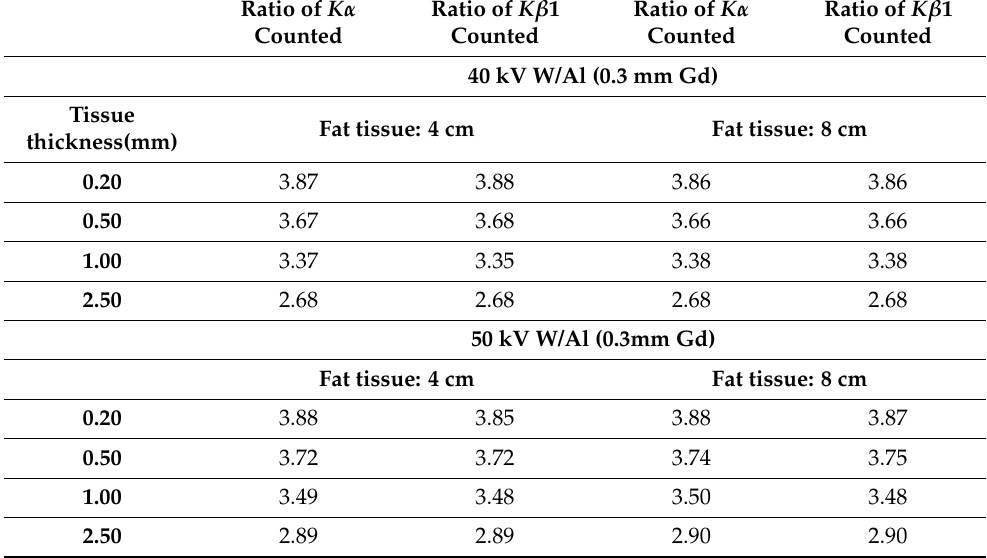
Table 4. Table shows the ratio of K -X-rays counted ( K α and K β 1 ) by the 700 µ m Si converter layer between tumor and fibrous tissue. Results are provided for: (a) two X-ray spectra: 40 kV- W/Al (1.6 mm) and 50 kV- W/Al (1.6 mm) with additional filtration 0.3 mm Gd; (b) two types of internal tissue (fibrous and tumor) with thicknesses ranging from 0.2 mm up to 2.5 mm; and (c) external fat tissue of 4 cm and 8 cm thickness. Numerical evaluations obtained by the deviation of their mean value. Ratio of K α Ratio of K β 1 Ratio of K α Ratio of K β Counted Counted Counted